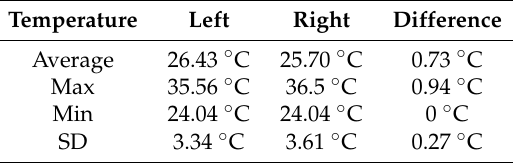
Table 4. Statistical values of the temperatures of the segmented left and right breast areas and difference estimation for Case